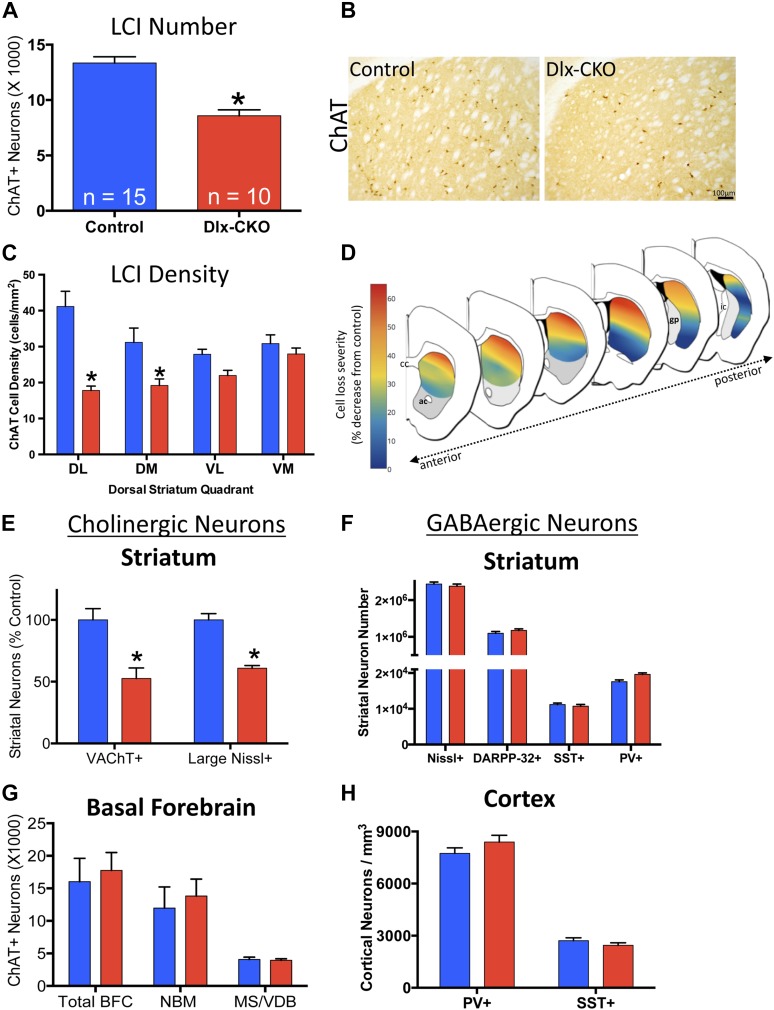
Large cholinergic interneurons are selectively Lost from the striatum of Dlx-CKO mice.(A, B) Stereological quantification of the number of ChAT-positive neurons in the striata of Dlx-CKO and littermate control mice (t-test: t(23) = 5.87; p < 0.0001). (C) Characterization of the topology of ChAT-positive cell loss in dorsal striatum. Significant decreases in ChAT-positive cells were observed only in the dorsal quadrants. Two-way ANOVA main effects of genotype: F1,56 = 38.17; p < 0.0001 and interaction: F3,56 = 6.405; p = 0.0008. (D) Pseudocolor representation of the degree of ChAT-positive cell loss in the dorsal striatum of Dlx-CKO mice. (E) Stereological quantification of the number of VAChT-positive and large (>20 μm diameter soma) Nissl-stained cells. VAChT t(13) = 3.305; p = 0.005, Nissl t(13) = 5.293; p = 0.0001. (F) Stereological quantification of the number of striatal small/medium (<20 μm diameter soma) nissl-positive cells (nissl+, t(13) = 0.606; p = 0.549), medium spiny neurons (DARPP-32+: t(22) = 1.14; p = 0.266), and SST- and PV-expressing inhibitory interneuron classes (PV+: t(23) = 2.806, p = 0.01 SST+: t(23) = 0.6865; p = 0.499). (G) Stereological quantification of the number of ChAT-positive neurons in basal forebrain nuclei (BFC—Basal Forebrain Complex, MS—Medial Septum, VDB—Vertical Limb of the Diagonal Band) of Dlx-CKO and littermate control mice (t(7) = 0.392; p = 0.706). (H) Stereological quantification of the number of cortical SST- and PV-expressing inhibitory interneuron classes (PV+: t(15) = 1.32; p = 0.206; SST+: t(15) = 1.18; p = 0.256).